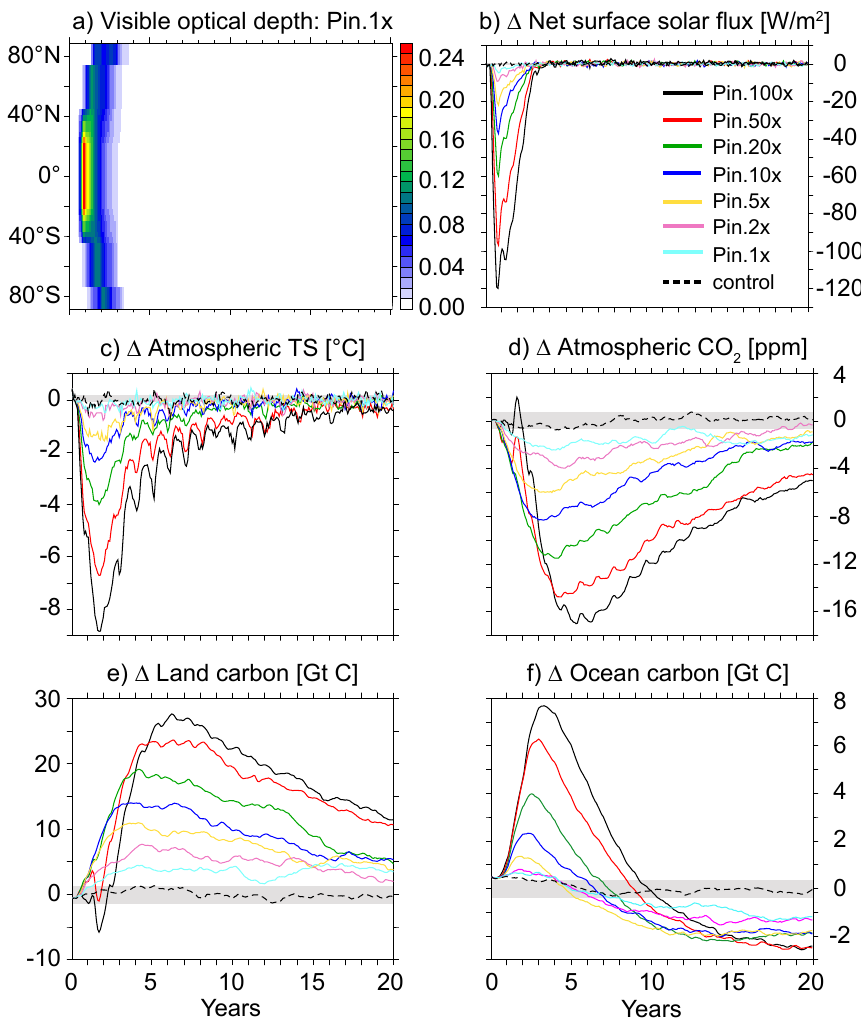
Fig. 1. (a) Prescribed zonal averaged stratospheric optical depth in the mid-visible wavelength for the Pin.1x case. (b–f) Global mean responses of the carbon cycle-climate system to different strengths of volcanic eruptions: time series of monthly (b) net surface solar flux, (c) atmospheric surface temperature, (d) atmospheric CO 2 concentration, (e) land carbon inventory and (f) ocean carbon inventory (sum of dissolved inorganic and organic carbon). In all plots in (b–f) and for all cases, the mean annual cycle from the control simulation has been removed. The volcanic eruptions start after half a year. The grey bar shows one standard deviation from a 280-yr control simulation. The control simulation has first been detrended with a 50-yr spline before calculating one standard deviation for the land and ocean carbon inventory to remove the artificial long-term